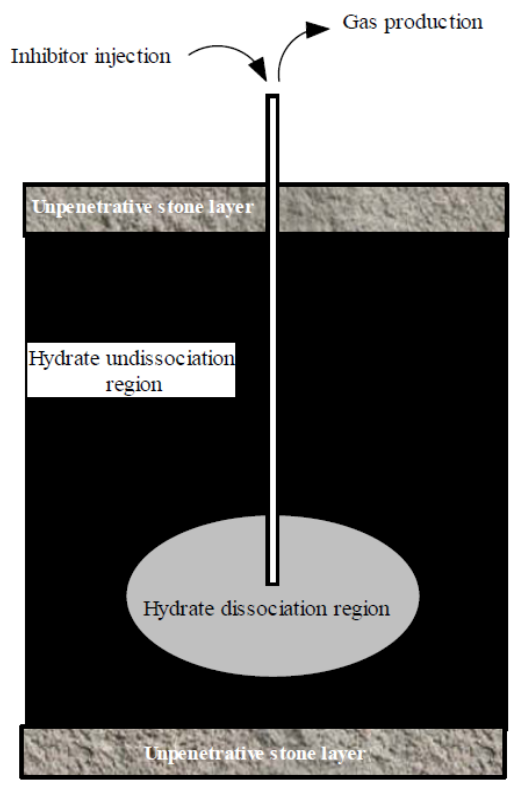
Figure 8. Gas production from hydrate by the chemical injection